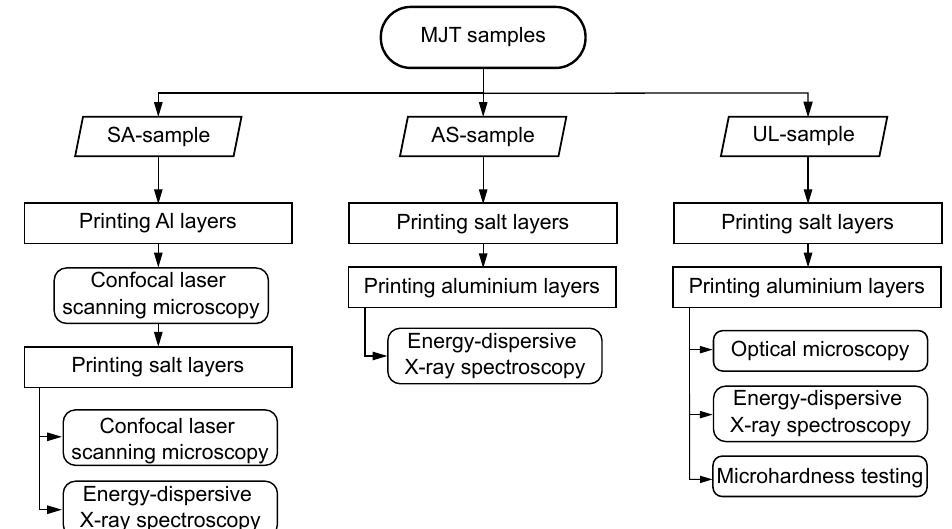
Figure 5. Flow chart of the experimental procedure. Three sample geometries (SA-sample, AS- sample and UL-sample) are printed out of aluminum and salt via Material Jetting (MJT). For the SA-sample, the aluminum layer is printed first and then analyzed using confocal laser